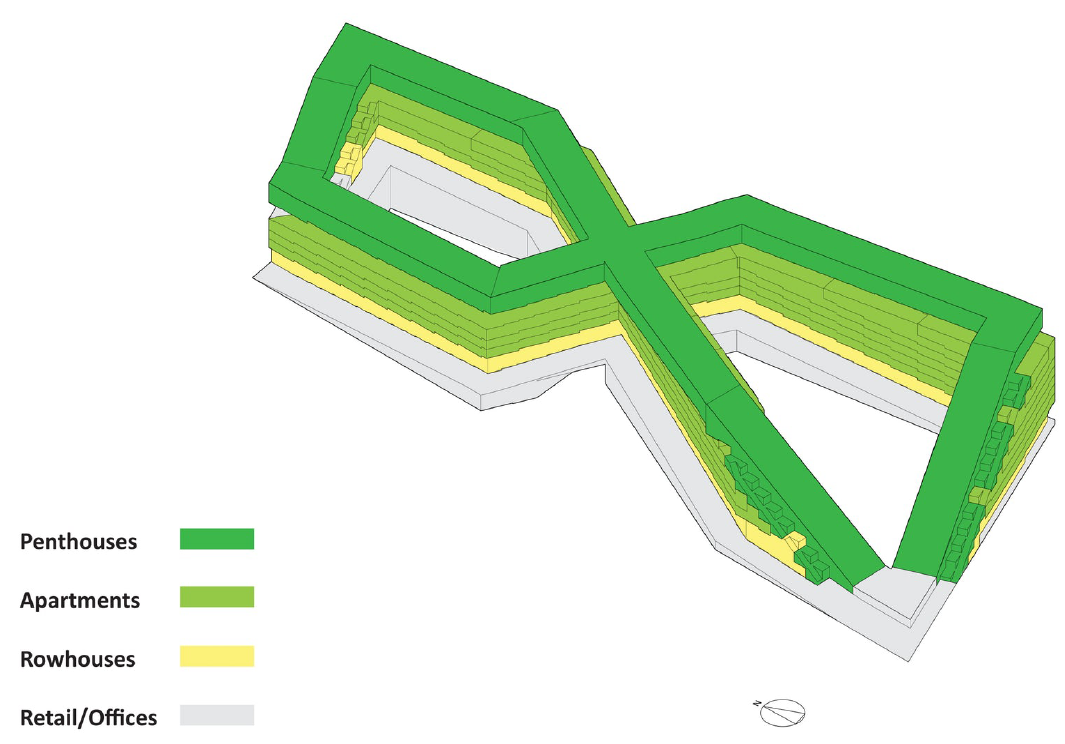
Figure 8. The number 8 layout—the 8 House. Source: Minner (2010).